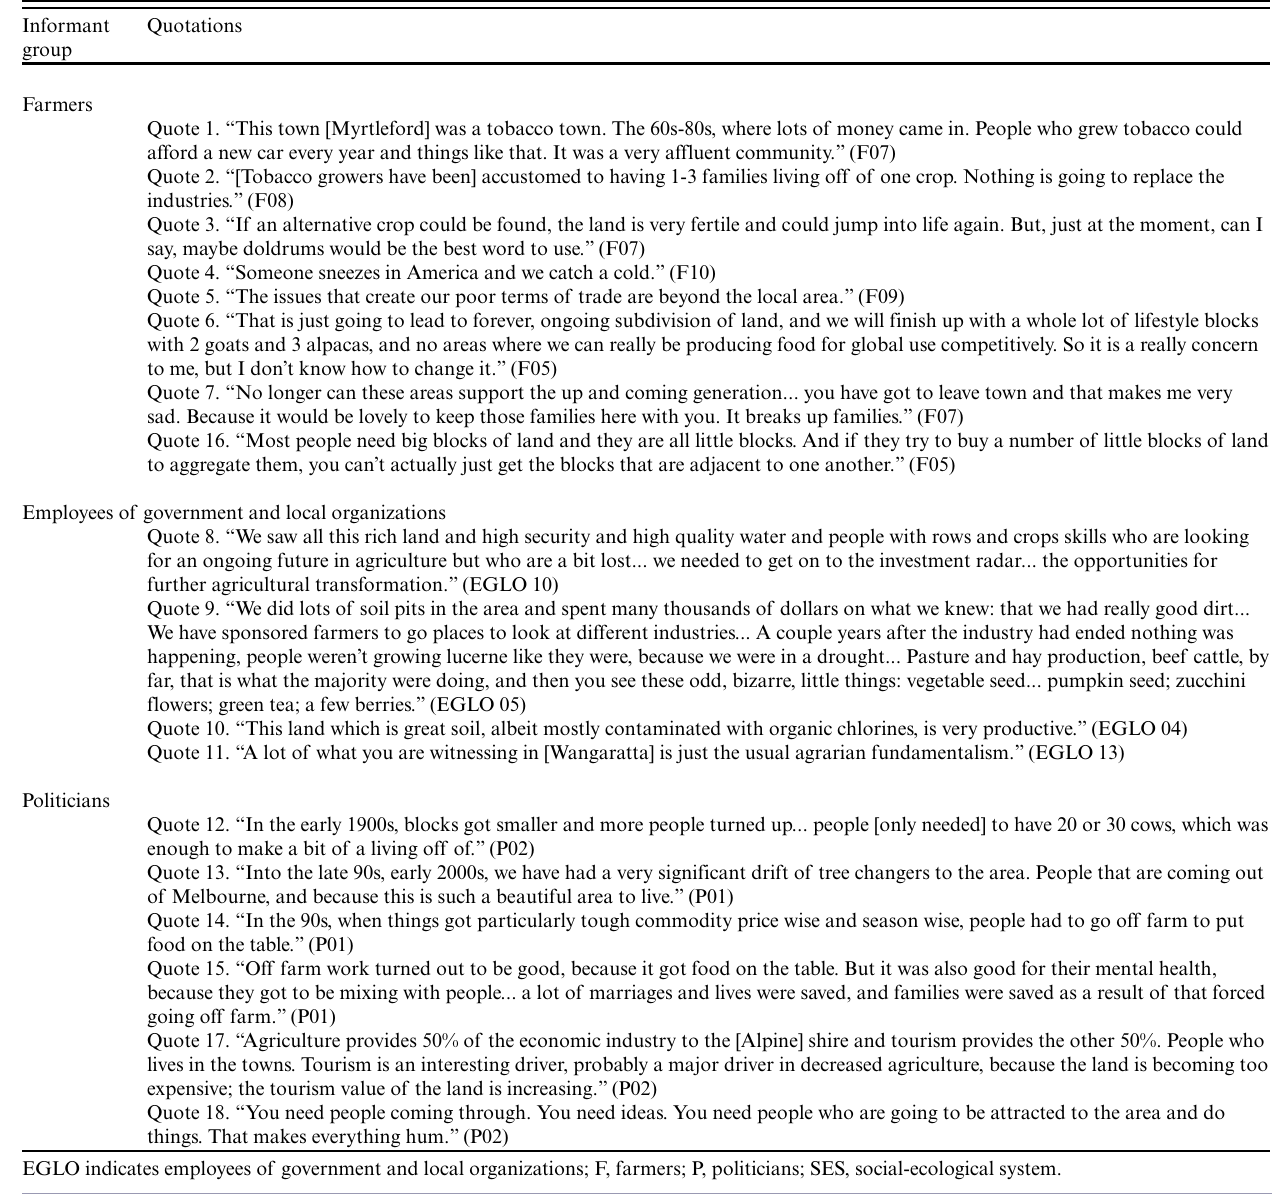
Table 1 . Quotations from three informant groups that describe SES change differently. The informant groups were farmers, employees of government and local organizations, and